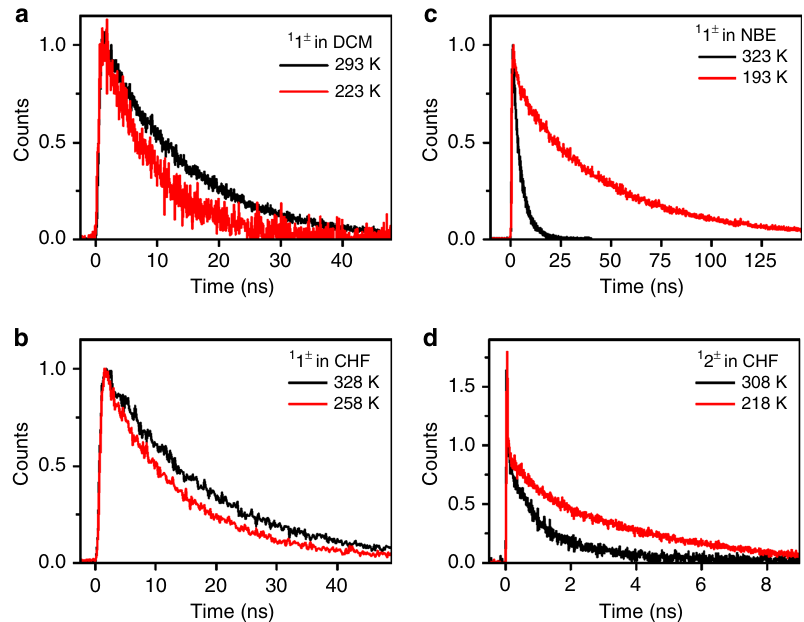
Fig. 3 Fluorescence decays. Fluorescence decays at various temperatures of 1 1 ± in dichloromethane ( a ), 1 1 ± in chloroform ( b ) and 1 1 ± in di- n -butyl ether ( c ), normalized at maximum, and 1 2 ± in chloroform ( d ) normalized at 100